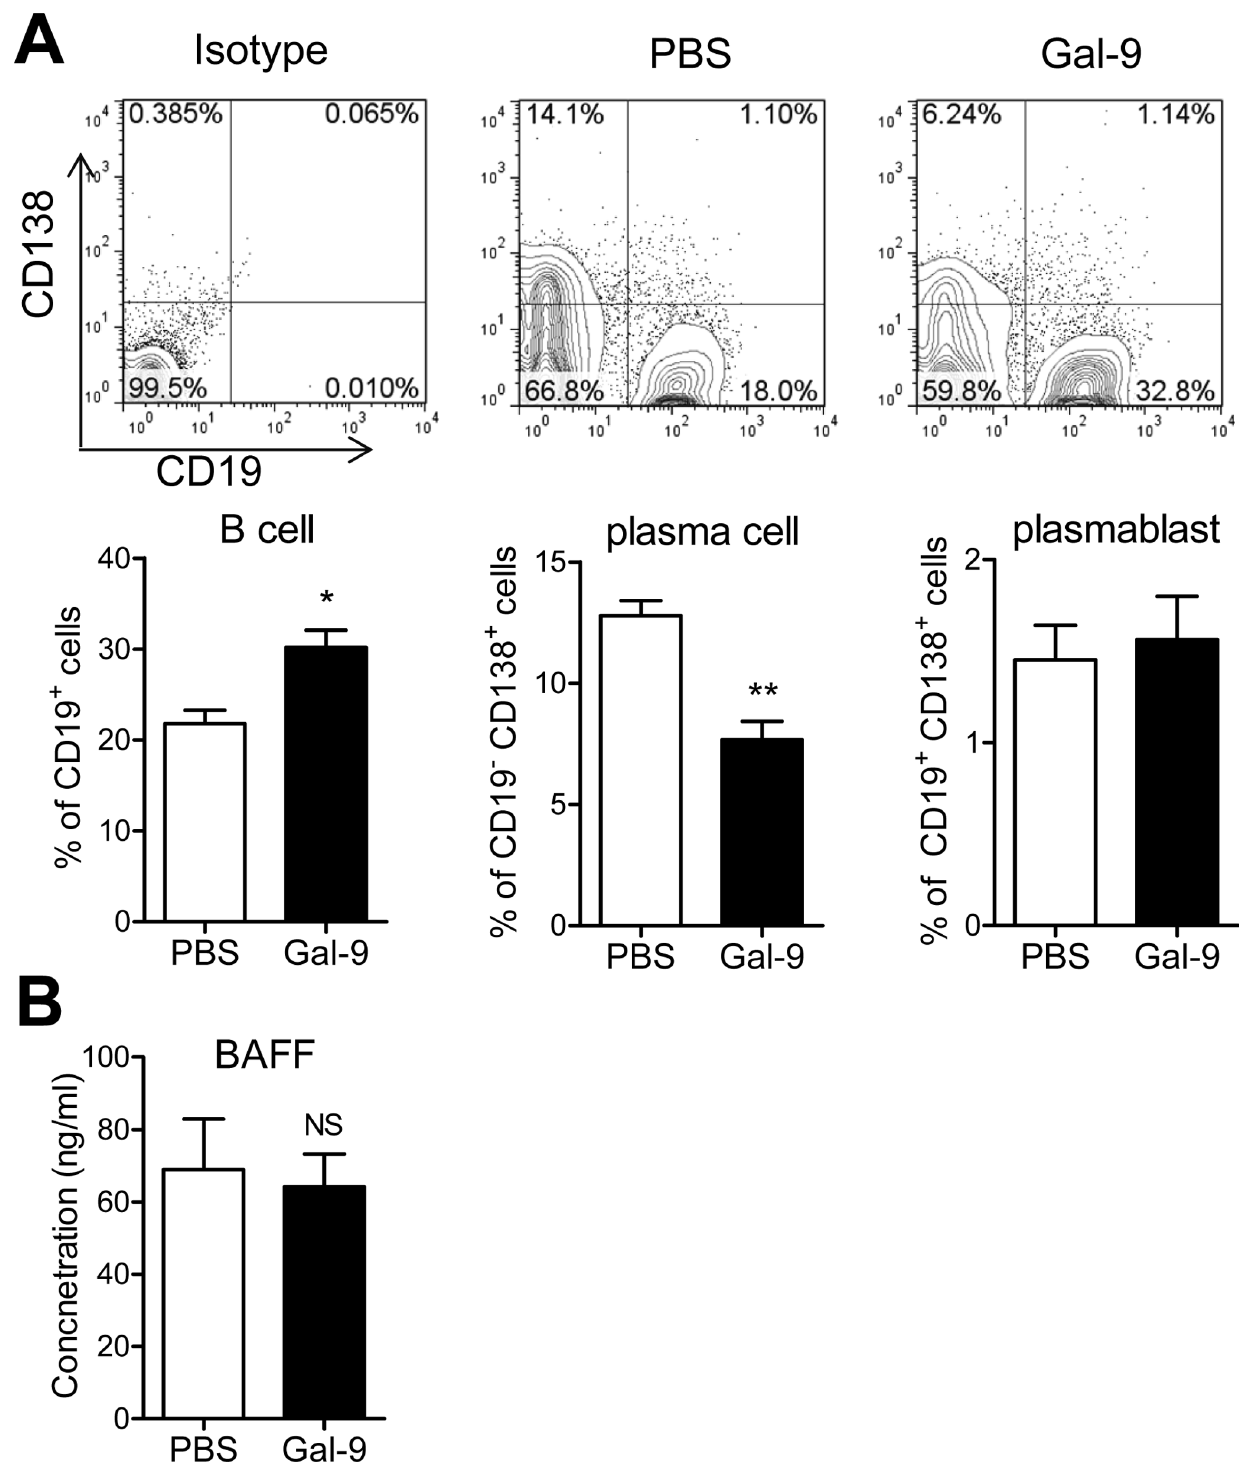
Figure 6. Gal-9 decreases spleen plasma cells in MRL/lpr mice. ( A ) Comparison of the percentage of B cells, plasma cells, and plasmablasts in the spleen of 12-week-old PBS-treated (n=4) and Gal-9-treated (n=4) mice. (*, P , 0.05, **, P , 0.01). Representative data of flow cytometric profiles are shown. ( B ) Comparisons of the level of BAFF between PBS-treated (n=7) and Gal-9-treated (n=8) mice at 12-weeks. (NS, not significant).D.